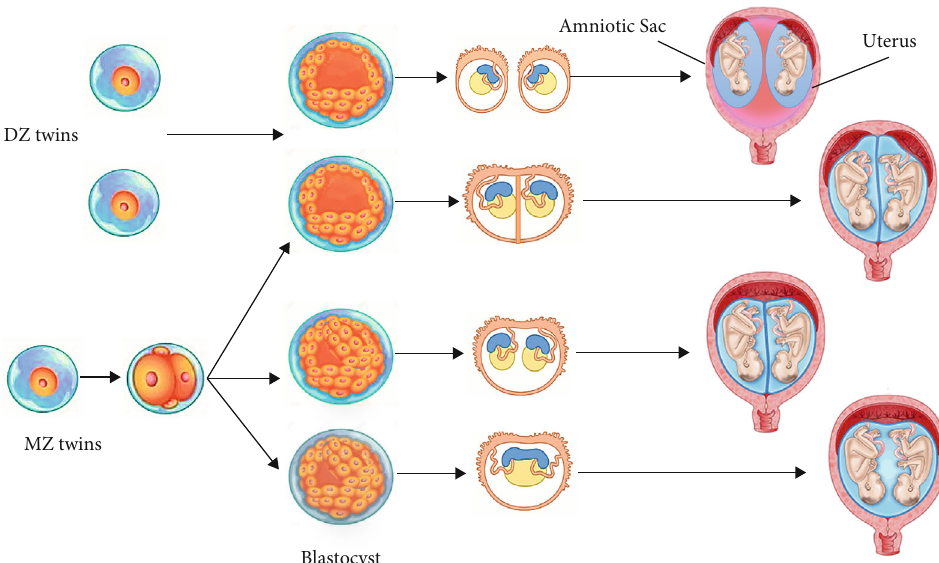
Figure 2: Natural twinning